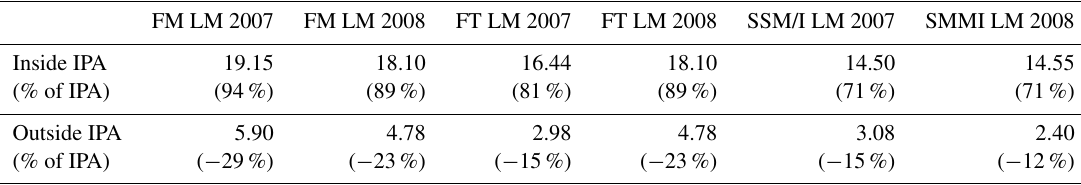
Table 5. Comparison of satellite data results based on modelled ground temperatures with permafrost extent from Brown et al. (1997). Covered area in percent inside and outside permafrost regions. FT – days identified as frozen without melting snow are used; FM – days with melting snow are considered to be frozen ground; LM – model